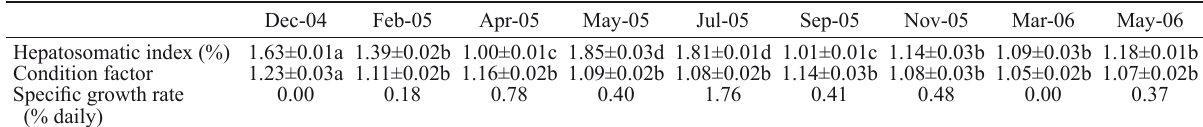
Table 2. – Seasonal growth performance indices in A. regius specimens cultured in earthen ponds. Further details as in legend of Figure 2.